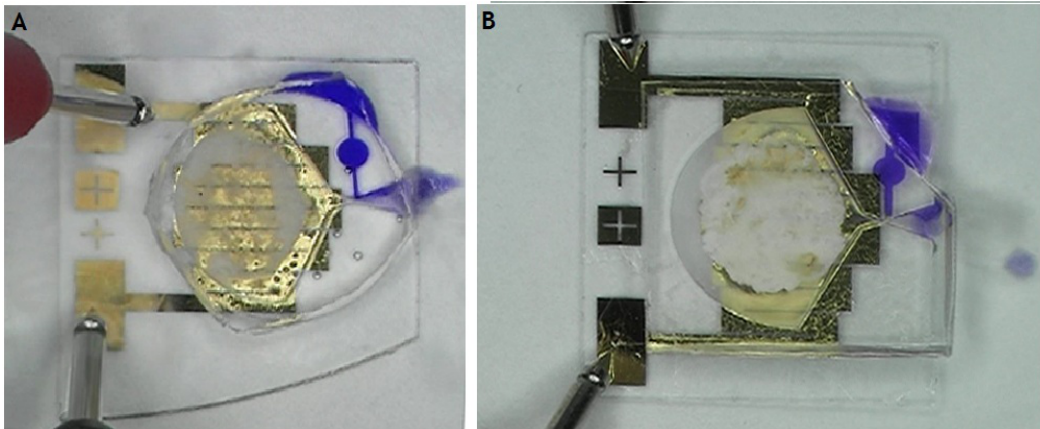
Figure 10. The gathering evaluation experiments. (a) The PDMS gathering tool gathers the diluted ink in the reservoir. (b) The PMMA gathering tool gathers the diluted ink in the